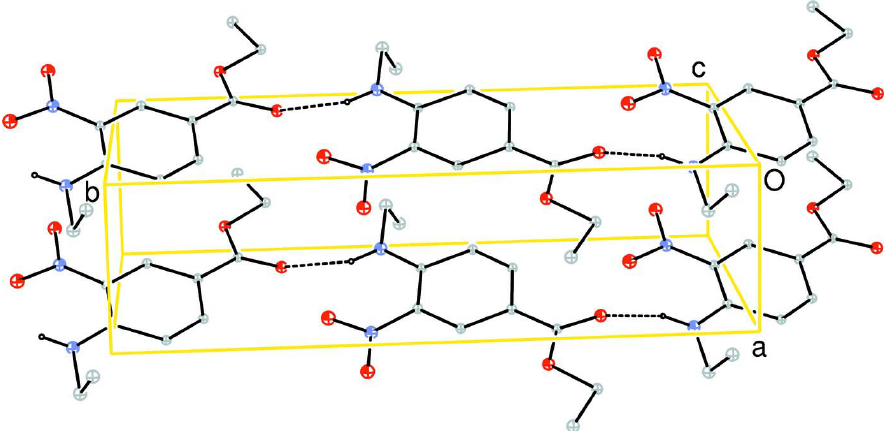
Figure 1 The molecular structure of the title molecule, with the atom-numbering scheme. Hydrogen bond is shown as dashed line.